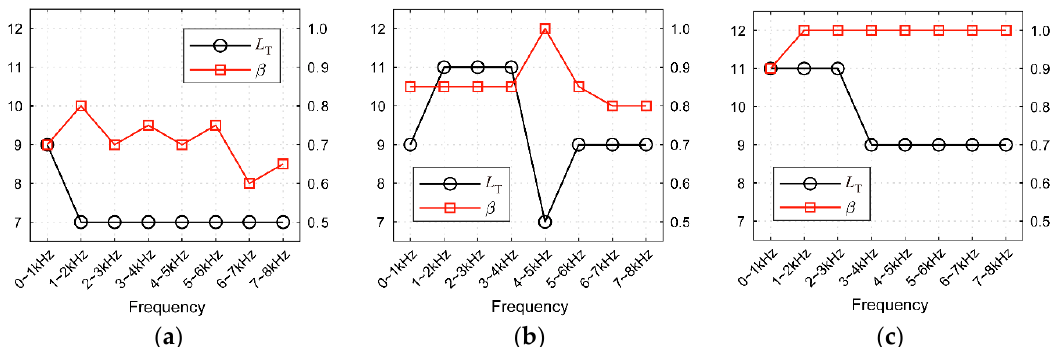
Figure 2. Optimal L T and β of male speech according to frequency intervals in ( a ) 0.37 s, ( b ) 0.69 s, and ( c ) 0.79 s of RT 60 with a 25-ms Hamming window, 10-ms hop length, and 512-point FFT.